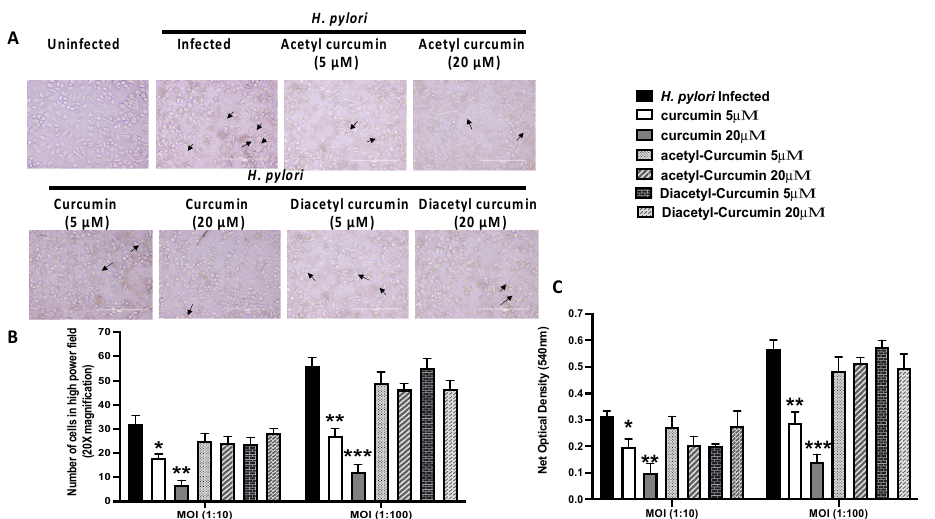
Figure 6. Effect of curcumin and non-oxidizable derivatives on H. pylori mediated VacA vacuolation activity in AGS cells. ( A ) Light microscopy images showed uninfected AGS cells. The black arrow indicated the vacuolation region in H.pylori -infected AGS cells pretreated with curcumin and non-oxidizable curcumin. ( B ) The histogram graph represented the inhibition of vacuolation activity in H. pylori-infected AGS cells at two MOI (10:1, 100:1) and pretreated with curcumin and non-oxidizable curcumin. ( C ) The histogram graph showed neutral red uptake by AGS cells at OD 540 nm in H. pylori-infected AGS cells at two MOI (10:1, 100:1) and pretreated with curcumin and non-oxidizable curcumin. (* p value < 0.05; ** p value < 0.01; *** p value < 0.001 vs. H. pylori infected). Data are expressed as means ± SEM, n = 3 independent replicates.